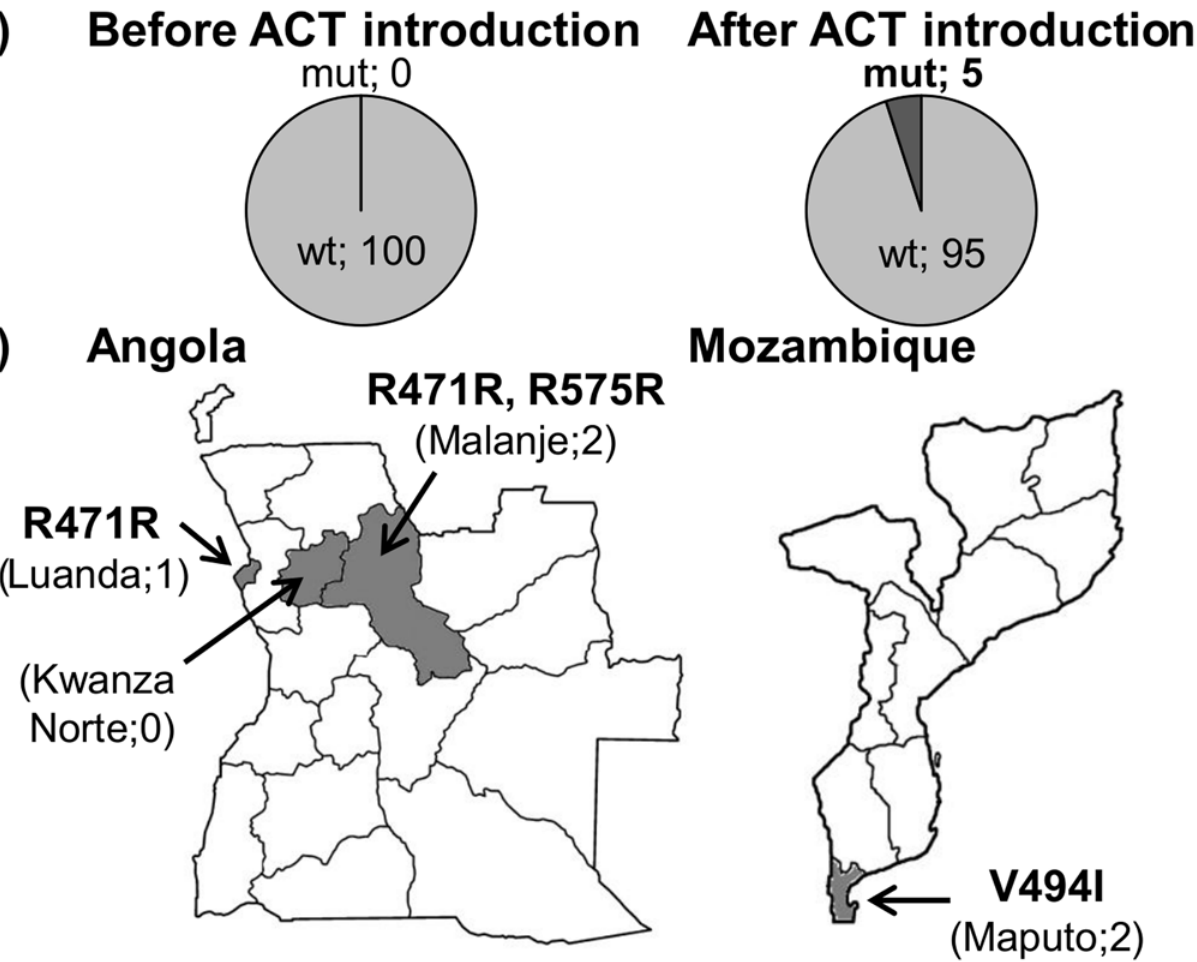
Fig 1. P. falciparum K13-propeller polymorphisms prevalence and distribution in Angola and Mozambique. Panel 1) Proportion within each time period of wild type (wt) and mutant (mut) samples; Panel 2) Geographical location of sample collection (dark grey) and identified polymorphisms. doi:10.1371/journal.pone.0119215.g001 Table 1. P. falciparum K13-propeller amino acid and nucleotide substitutions observed in Angola and Mozambique.